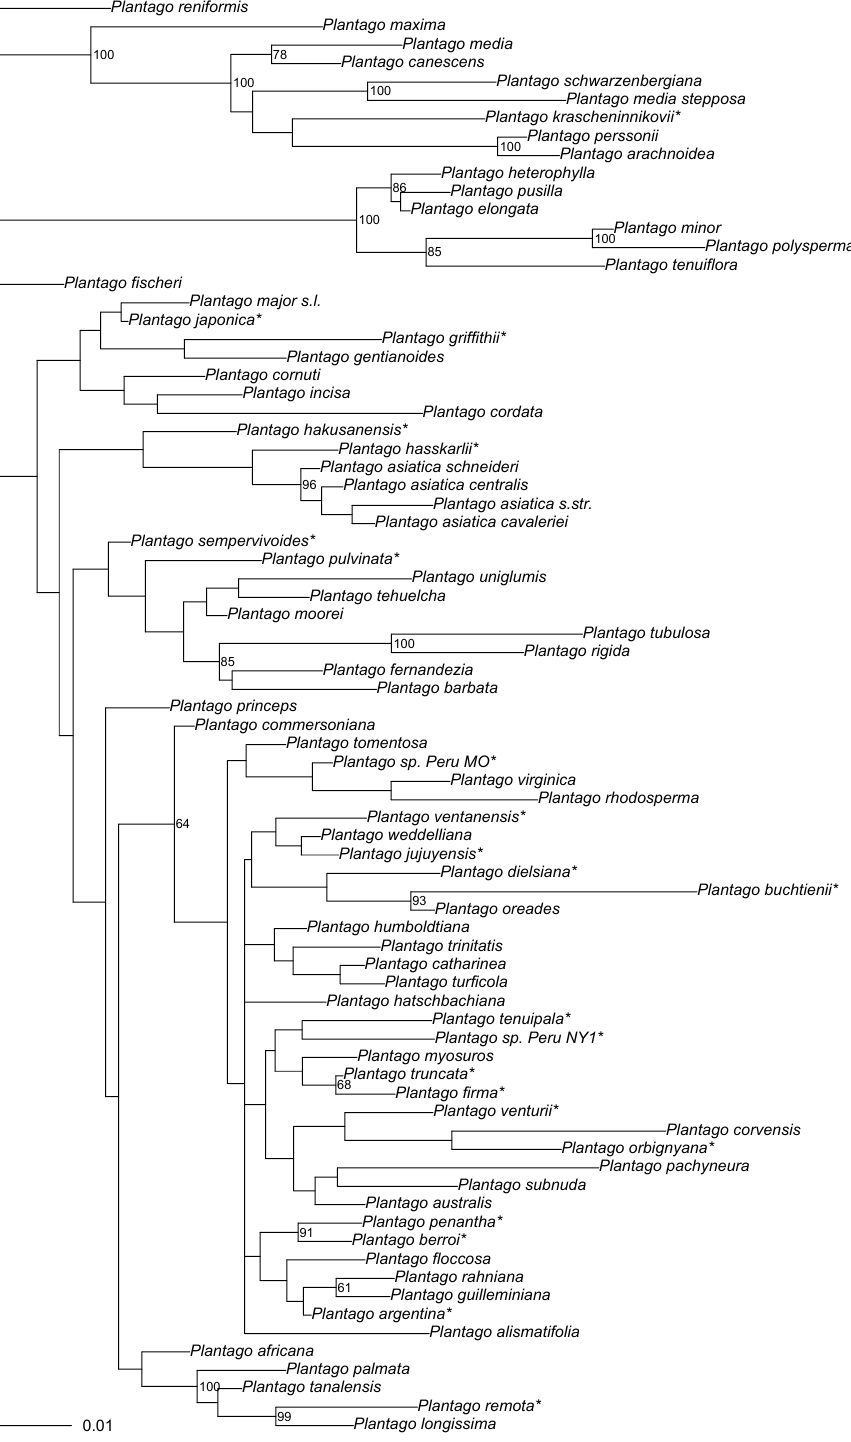
Figure 5. The phylogeny of Plantagineae obtained from the “tall” dataset (based on MB trees). ( A ) Aragoa and Littorella . ( B ) Plantago subgg. Coronopus and Plantago (first part). ( C ) Plantago subg. Plantago (second part). ( D ) Plantago subgg. Bougueria , Albicans and Psyllium . Stars (*) mark species which have not been barcoded before. Numbers on nodes are Bayesian posterior probabilities